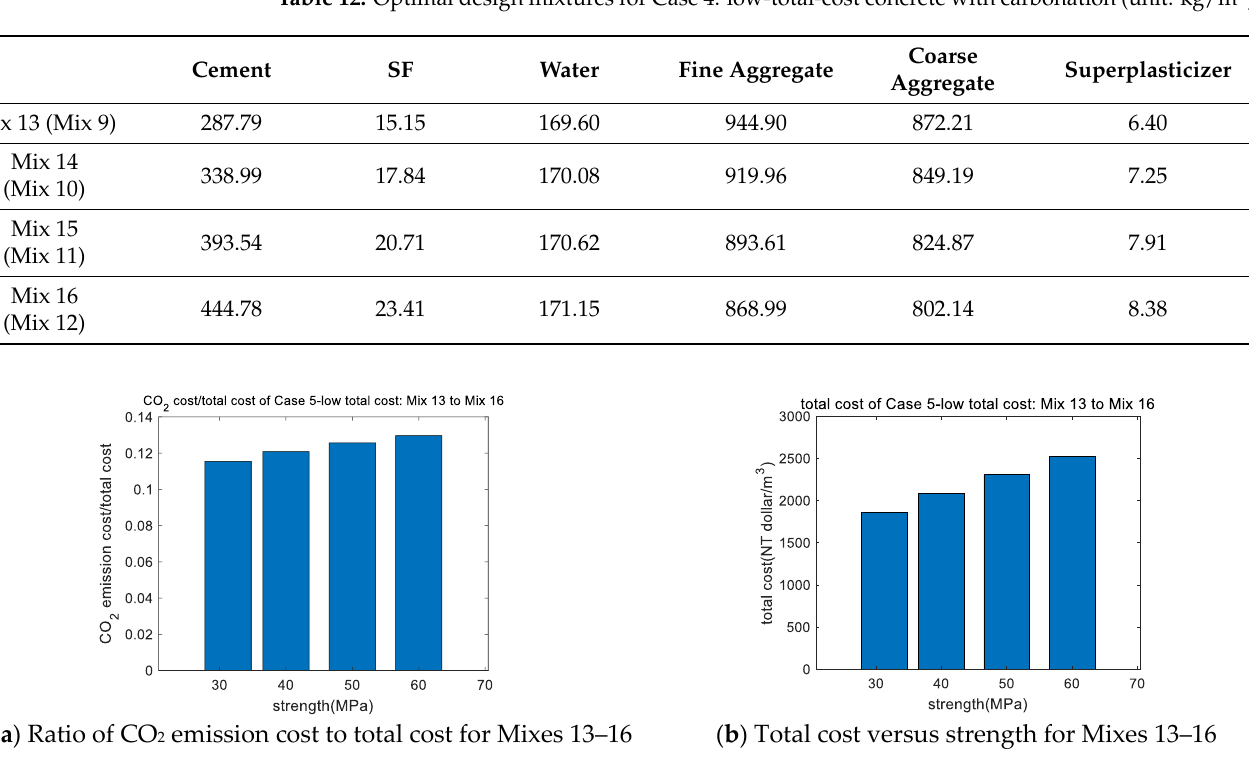
Figure 4. Performance of Case 3: Mixes 9 – 12 (low material cost).